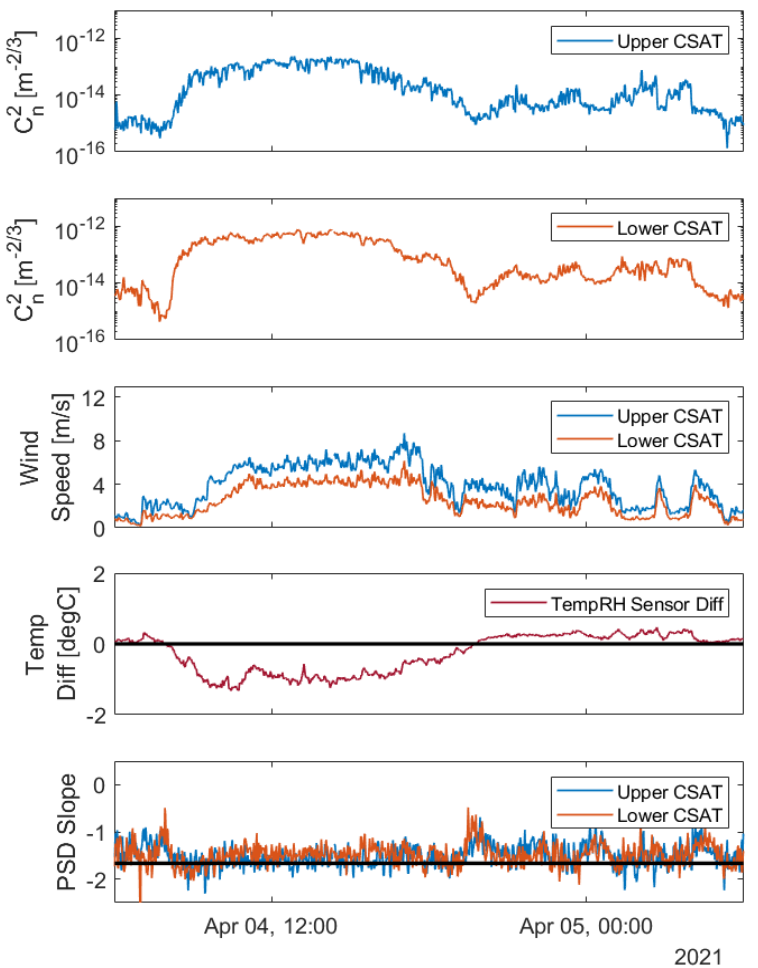
Figure 4. Data collected from 0600 Sunday, April 4 to 0600 Monday, April 5 (local time). The fourth plot of Figure 4 is the temperature difference between the upper and lower hygrometers. Here we see an expected trend of the lower temperature readings being greater than the temperature measured by the upper sensor due to its proximity to the heat-absorbing surface. Overnight, we reach a point of inflection as the ground cools and is momentarily at equilibrium with the temperature of the air at the higher elevation, shown with the solid black line plotted. As we enter the post-midnight hours, the ground is now cooler than the air at the higher elevation. It is also important to note that — as expected — the 𝐶 𝑛2 values of both sonics tend to be higher during periods of large negative temperature differences and tend to be lower during neutral conditions (i.e., when the temperature difference is zero). Other instances such as these will be further explored when we compare our results to NAVSLaM estimates. In the final plot of Figure 4, we have the slopes of the best line fit to the PSDs of both sonic anemometers; the expected value of −5 /3 slope was plotted as a solid black line. This plot was used to ensure that the probing frequency window (1 to 5 Hz) was sufficient to capture frequencies within the inertial subrange, as previously discussed. In the early morning hours of April 4th, the slope deviates drastically from the expected value of −5 /3; simultaneously, both sonic anemometers indicate a 𝐶 𝑛2 value of ~10 −16 m −2/3 . This may indicate that the sonics are approaching the noise floor which occurs when 𝐶 𝑛2 ≈ 10 −16 m −2/3 ; smaller values than this are difficult for these sonics to measure. We noted